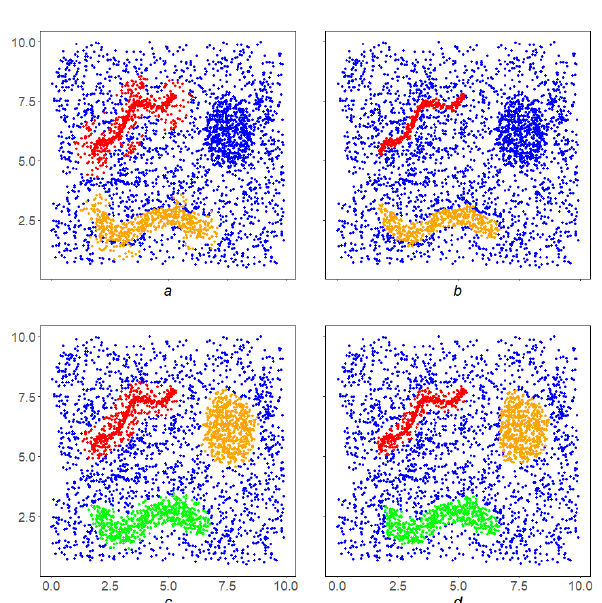
Figure 14. Result of the third and fourth stages of the LDPS algorithm. ( a ) The result of the third stage–the work of the GDPS algorithm; ( b ) the result of the fourth stage–the work of the MDPS algorithm; ( c ) the result of the DBSCAN algorithm; and ( d ) the result of the OPTICS algorithm.